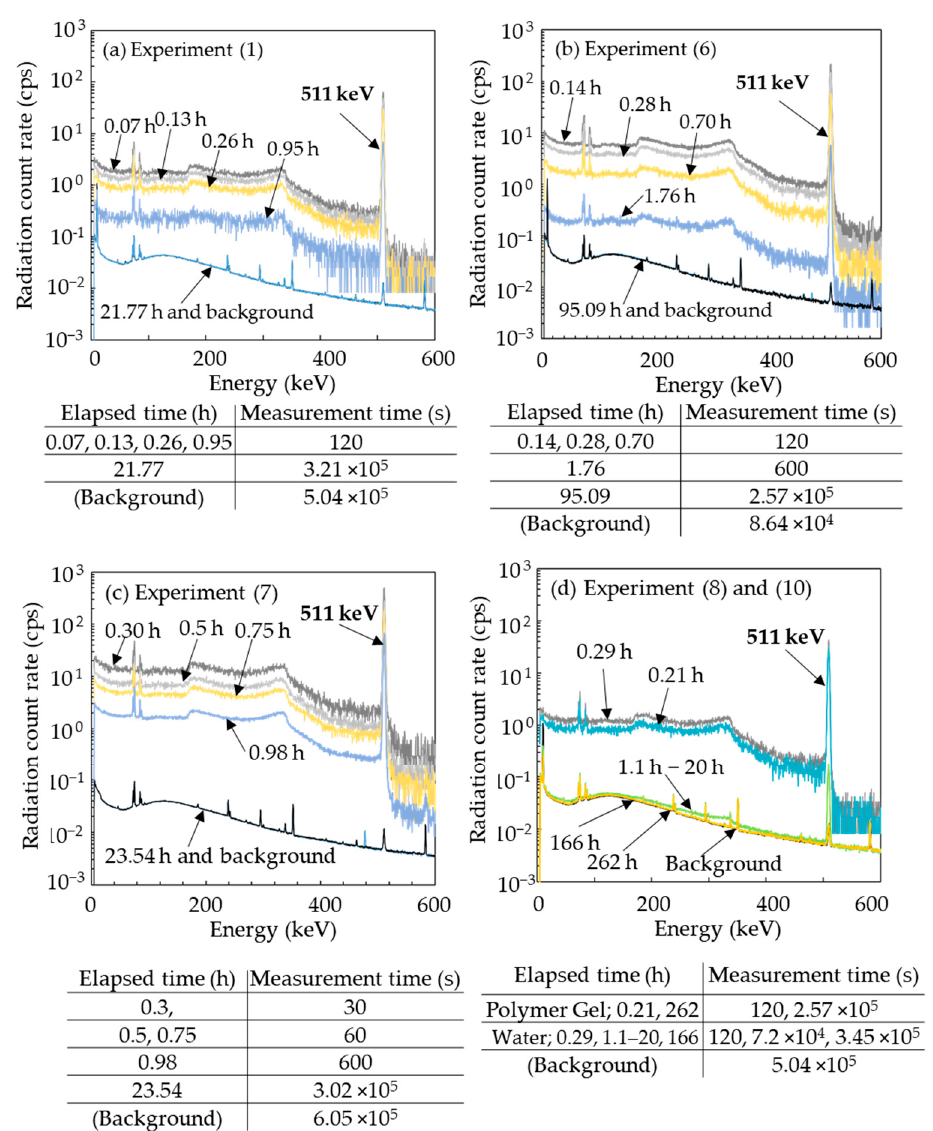
Figure 5. Gamma-ray spectra of selected specimens at different times after irradiation with carbon ion beam. ( a ): experiment (1), ( b ): experiment (6), ( c ): experiment (7), ( d ): experiment (8) and (10).